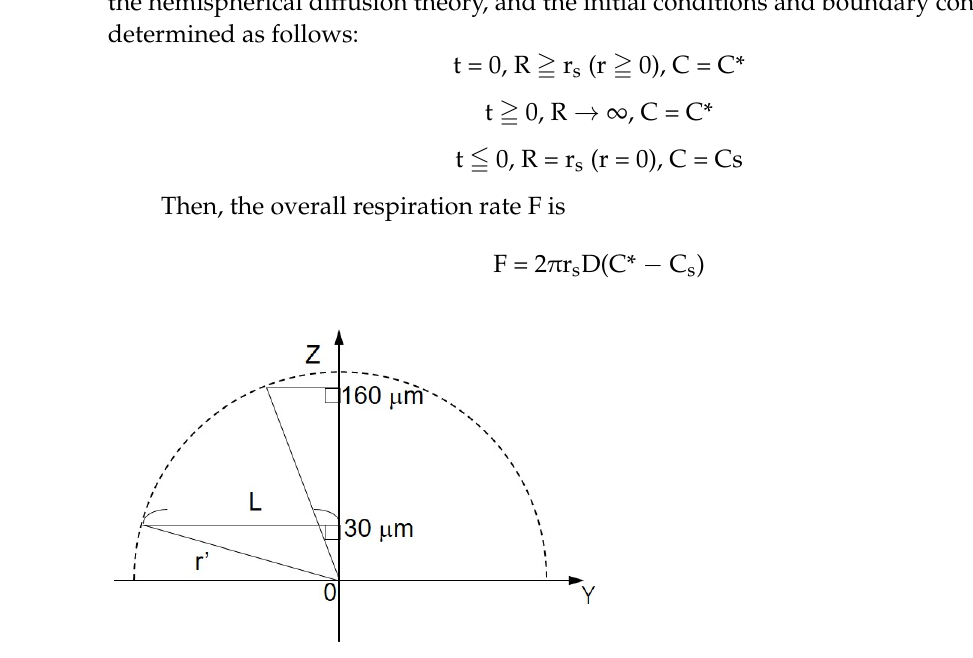
Figure 7. Schematic diagram of the oxygen concentration distribution on ZY plane. L, half the distance of the oxygen reduction current less than or equal to − 1.4 nA; Z’, the distance between Pt microelectrode and the cell chip; r’, oblique side of the right triangle.